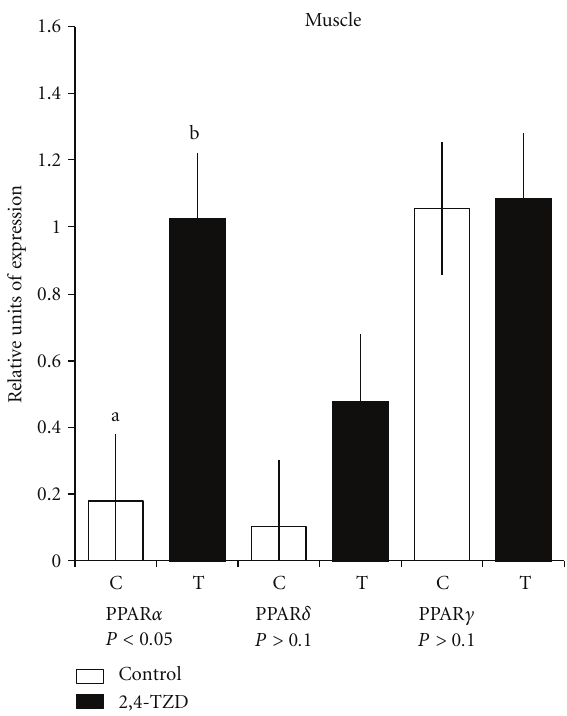
Figure 2: Quantitative polymerase chain reaction (qPCR) of perox- isome proliferation-activated receptors (PPAR) α , - δ , and - γ in the muscle. Columns show relative expression of PPAR ( α , δ , and γ ) in Control (C) and Thiazolidinedione (TDZ) (T) groups. a,b Di ff erent lowercase letters indicate a significant di ff erence.